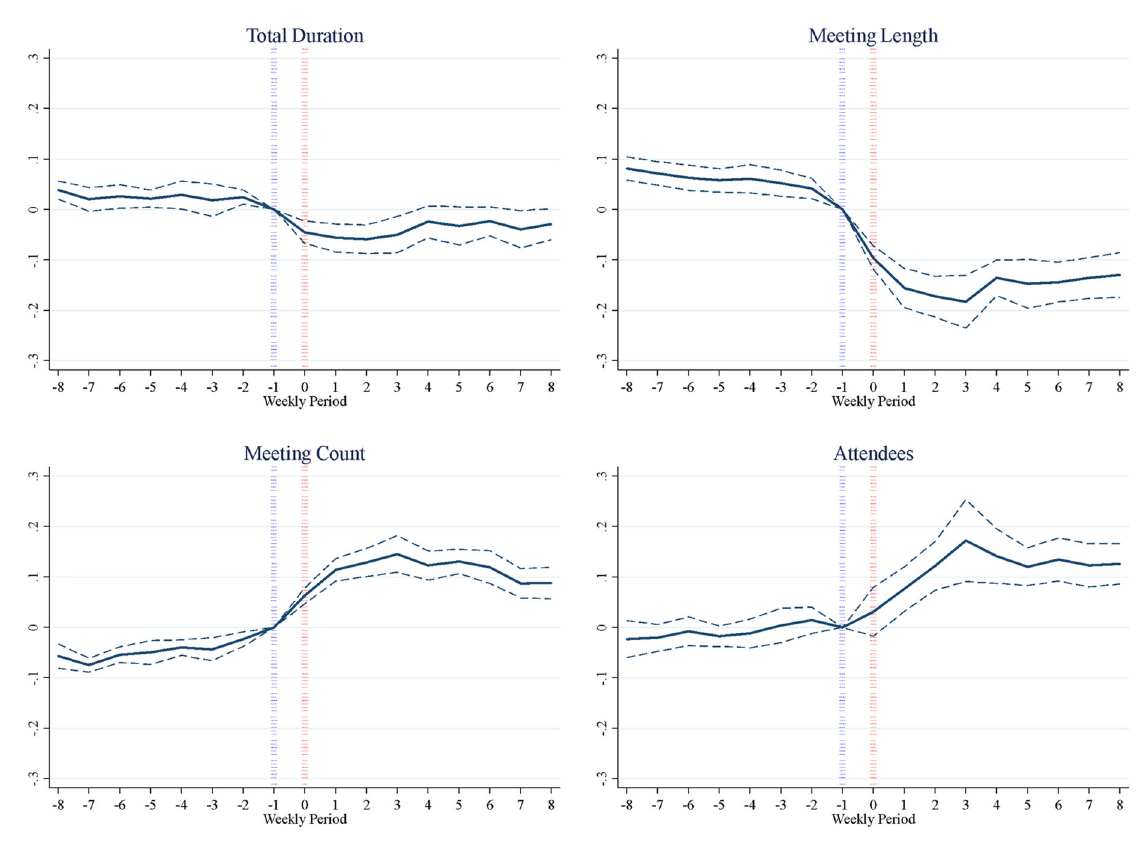
Fig. 1 Impact of COVID-19 lockdown on meeting measures. Depiction of the coef fi cients from Table